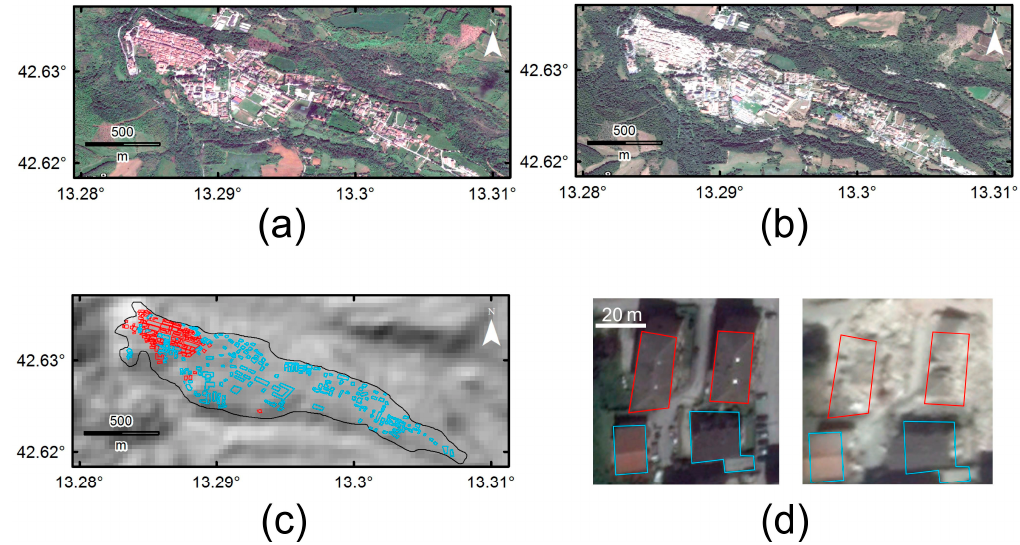
Figure 2. ( a ) Pre-event; and ( b ) post-event optical images of Amatrice, obtained by DigitalGlobe’s WorldView satellites; ( c ) Binary map produced by visual inspection; ( d ) Examples of binary classification. The blue polygons are ‘no damage’ buildings, and the red polygons are ‘collapsed’ buildings. It must be noted that in this study “no damage” buildings are not exclusively intact buildings. They may have structural or non-structural damages which are invisible in satellite images.